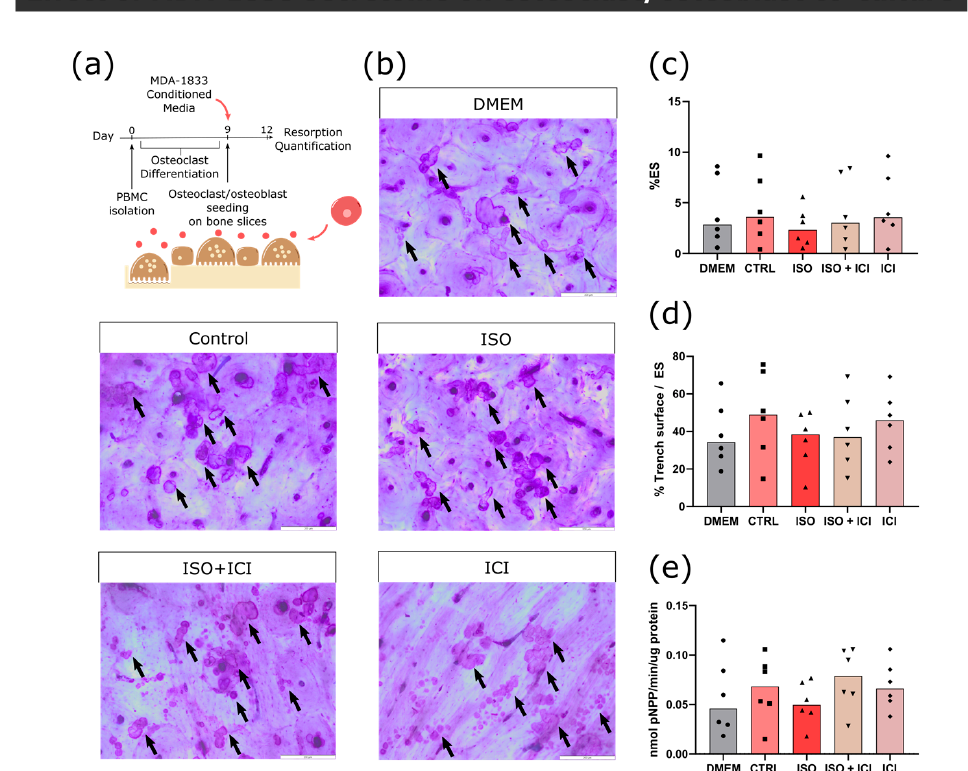
Figure 6. Effect of MDA-1833 secretome on osteoclast/osteoblast co-cultures. ( a ) Timeline of the resorption assay in a co-culture setting. Mature osteoclasts were seeded with osteoblasts and exposed to MDA-1833-conditioned media for three days. ( b ) Representative micrographs of the surface of bone slices after three days of resorption in co-cultures. Resorption events are highlighted by black arrows. Scale bar—200 µ M. ( c ) Estimated percentage of eroded surface, ( d ) trench percentage per total eroded surface and ( e ) TRAcP activity quantified at the end of the co-culture experiment. Data are expressed as the median of individual data points from six independent experiments (Friedman’s